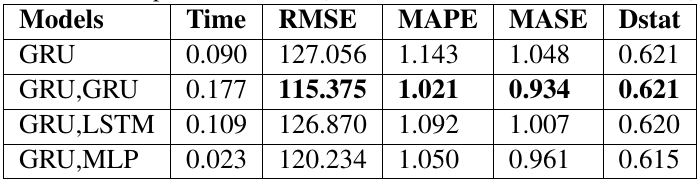
In Table 5, the performance of the proposed method (NN1:GRU, NN2:GRU) is also better than others. On the other hand, the values of the error-index (RMSE, MAPE, MASE) in Table 5 are bigger than those in Table 2 because the Standard Deviation values of data set 399001.SZ are bigger than that of data set 000001.SH. Table 5 The experiment results (NN1: GRU, DATA SET: